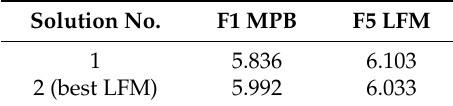
Table 10. Fitness functions for the pair F1–F5.